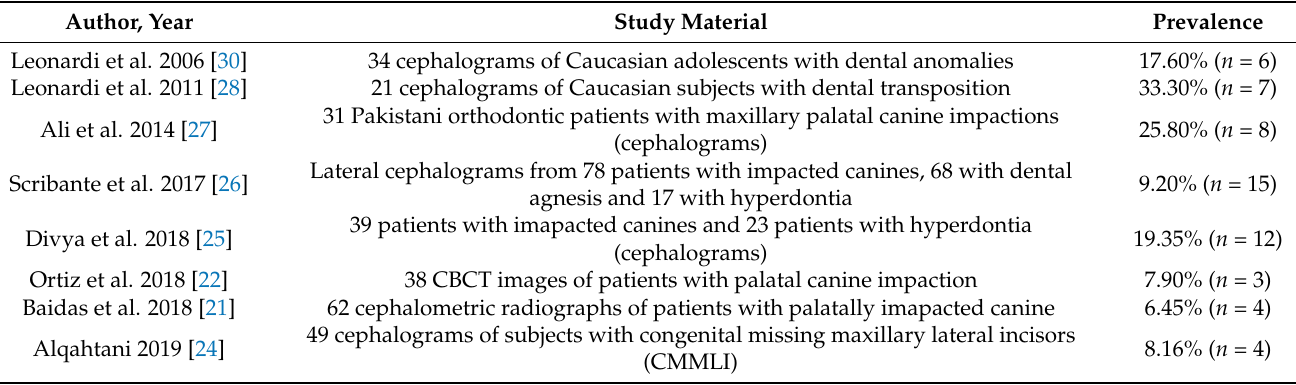
Table 5. Prevalence of complete sella turcica bridge in individuals with dental anomalies (in chronological order from earliest to most